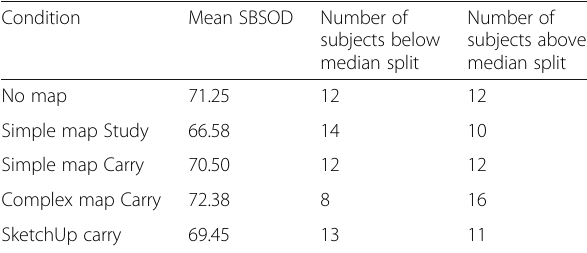
Table 1 Mean Santa Barbara Sense of Direction (SBSOD) scores for each experimental condition Condition